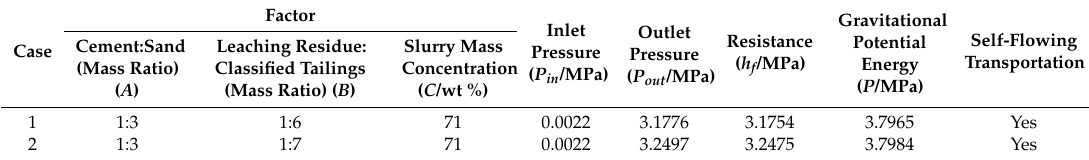
Table 6. The results of the compression strength test and diffusivity